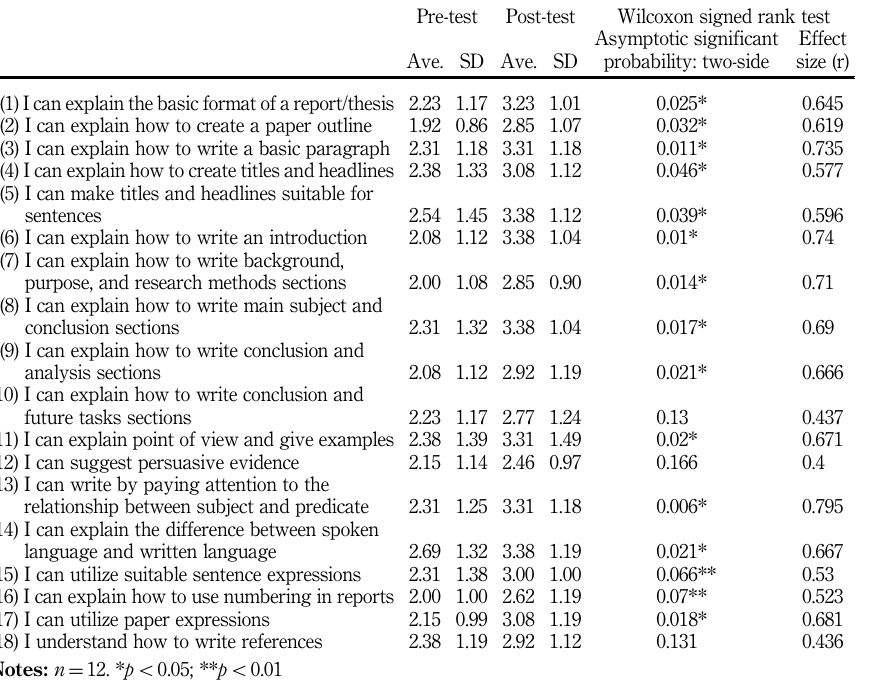
Table III. Results of pre- and post-test